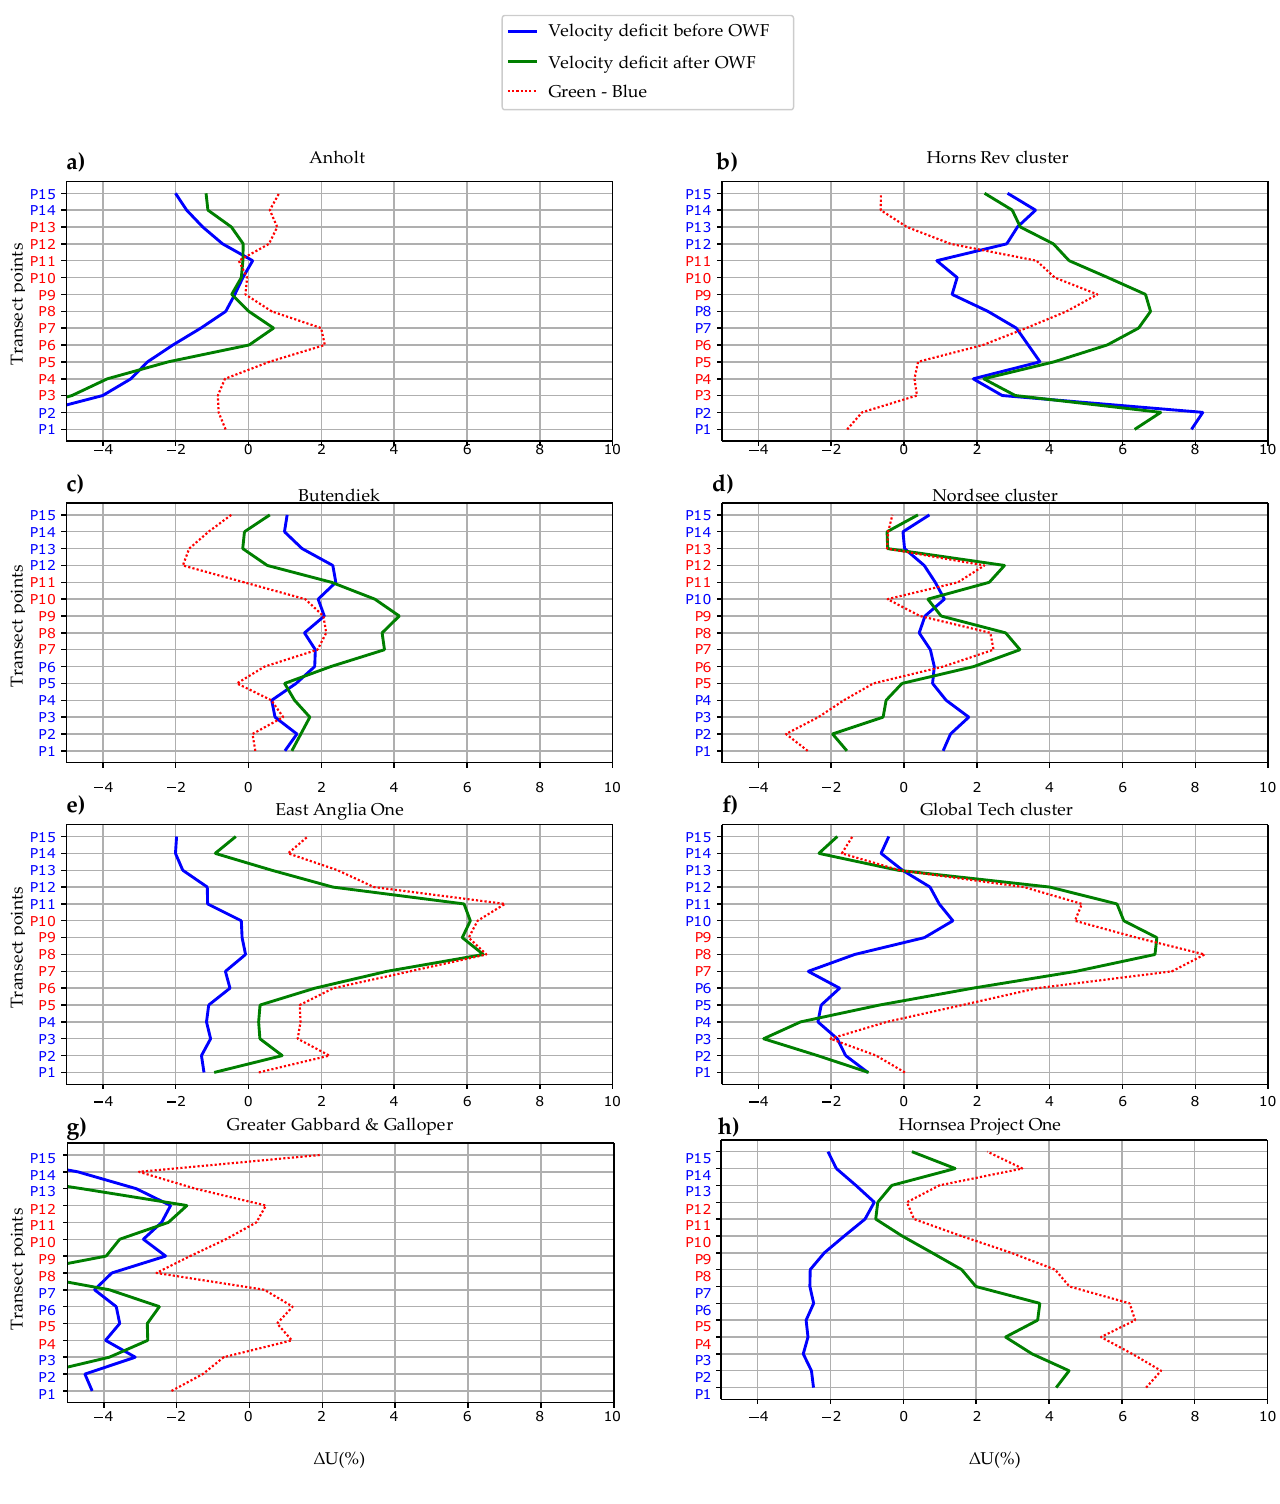
Figure 5. Velocity deficit ( ∆ U ) for westerly winds over the OWFs and clusters. The blue and green curves refer to periods before and after OWF commissioning, respectively. The red dotted line shows the ∆ U s once a correction for HCWSGs has been applied (i.e., subtraction of the blue curve from the green). ( a ) Anholt; ( b ) Horns Rev cluster; ( c ) Butendiek; ( d ) Nordsee cluster; ( e ) East Anglia One; ( f ) Global Tech cluster; ( g ) Greater Gabbard & Galloper; ( h ) Hornsea Project One.